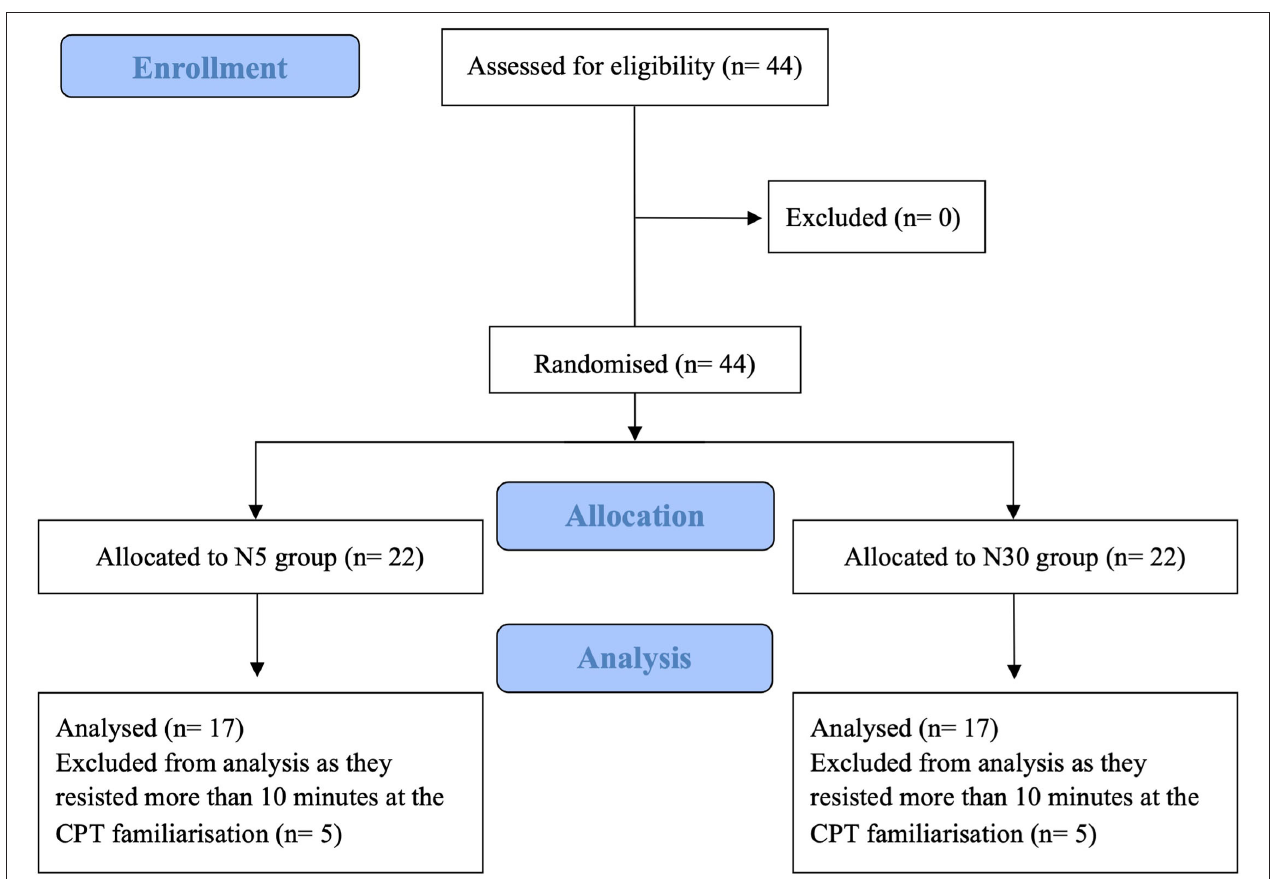
FIGURE 3 | CONSORT flow-diagram.